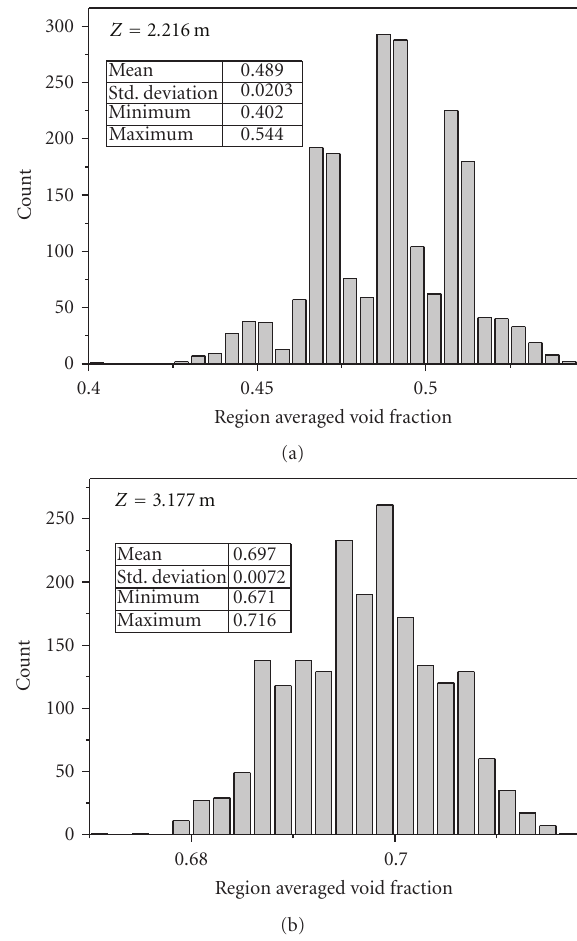
Figure 4: Uncertainty of predicted void fraction at various elevations for Run no.